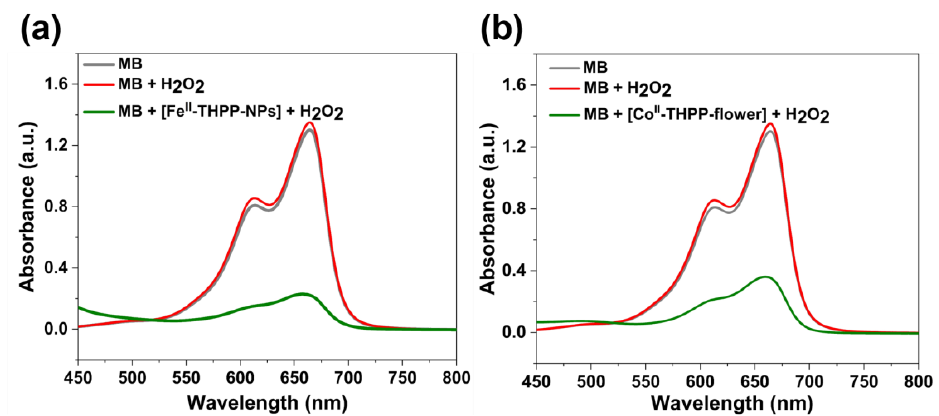
Figure 5. UV – Vis absorption spectra of MB, MB with H 2 O 2 , and MB with H 2 O 2 in the presence of [Fe II -THPP-NPs] ( a ) and [Co II -THPP-flower] ( b ) after incubation in PBS buffer for 30 min.